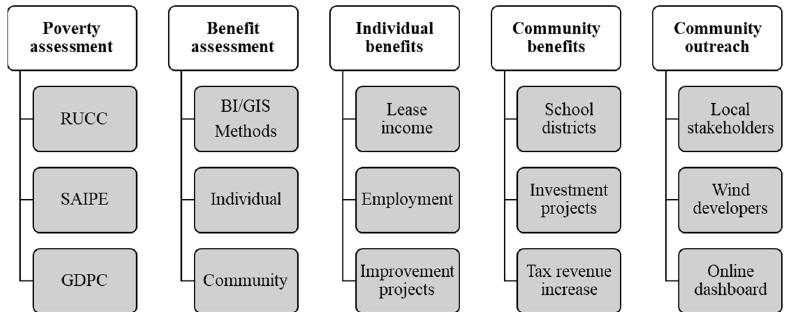
Figure 2. Flow chart for the high level description of the operational objectives of the method con- sidered for this research.